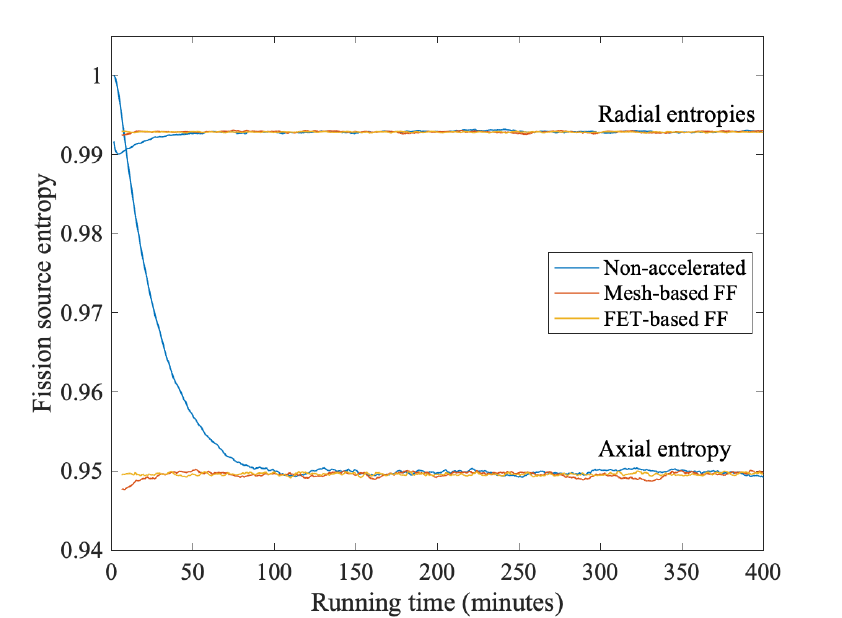
Figure 6: Fission source entropies for critical HZP configuration full-core test